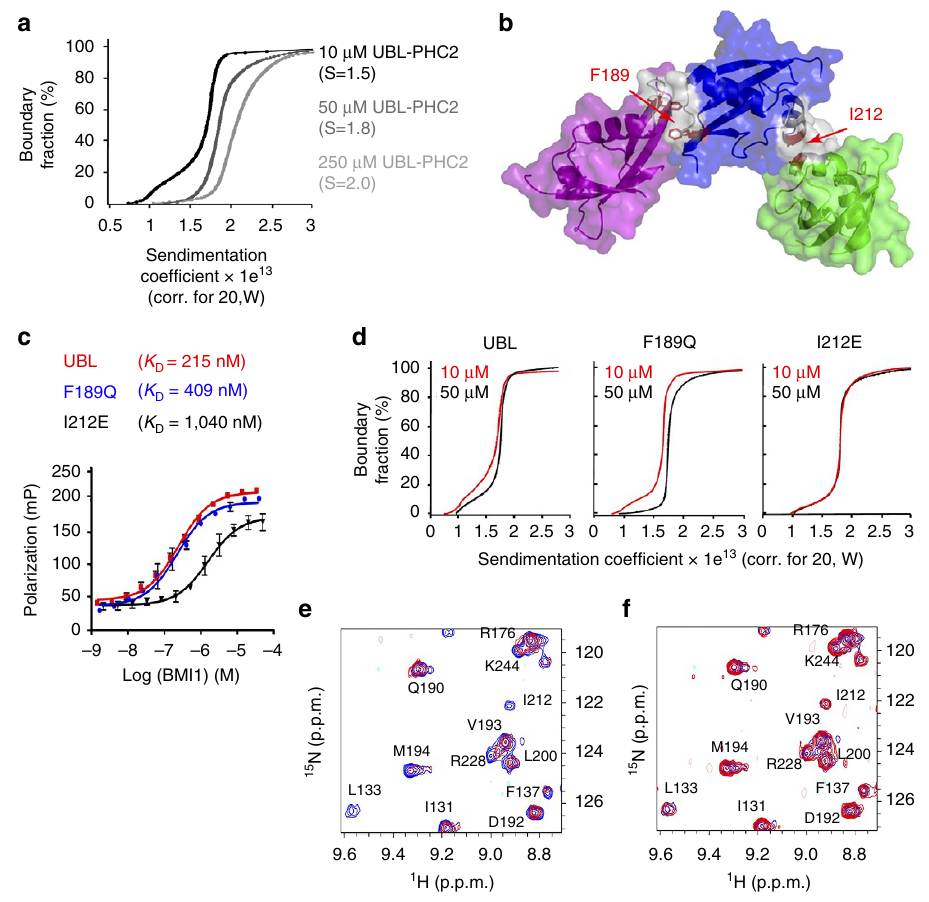
Figure 3 | BMI1 UBL forms higher order oligomers in solution. ( a ) Van Holde-Weischet [G(s)] plots of sedimentation distributions for wild-type BMI1 UBL–PHC2 1–79 complex showing a concentration dependent increase in particle size in solution. Values of sedimentation coefficients are in parenthesis. ( b ) The crystal structure of the BMI1 UBL domain showing two putative homo-oligomerization interfaces identified based on crystal packing. Residues selected for mutation to block homo-oligomerization are labelled. ( c ) Binding affinities of BMI1 variants with PHC2 1-79 determined using fluorescence polarization experiments titrating FITC–PHC2 32–61 with wild-type BMI1 UBL or point mutants. Experiments were performed in duplicates, error bars represent s.d.; K D is reported as the average and s.d. from three independent experiments. ( d ) Van Holde-Weischet [G(s)] plots of sedimentation distributions for BMI1 UBL–PHC2 1–79 complexes at 10 and 50 m M comparing the wild-type BMI1 and point mutants F189Q and I212E. ( e ) Superposition of 1 H– 15 N HSQC spectra for 50 m M 15 N BMI1 UBL–PHC2 33–56 complex in the absence (blue) and presence of 100 m M unlabelled BMI1 UBL–PHC2 33–56 complex (red). ( f ) Superposition of 1 H– 15 N HSQC spectra for 50 m M 15 N BMI1 UBL–PHC2 33–56 complex in the absence (blue) and presence of 100 m